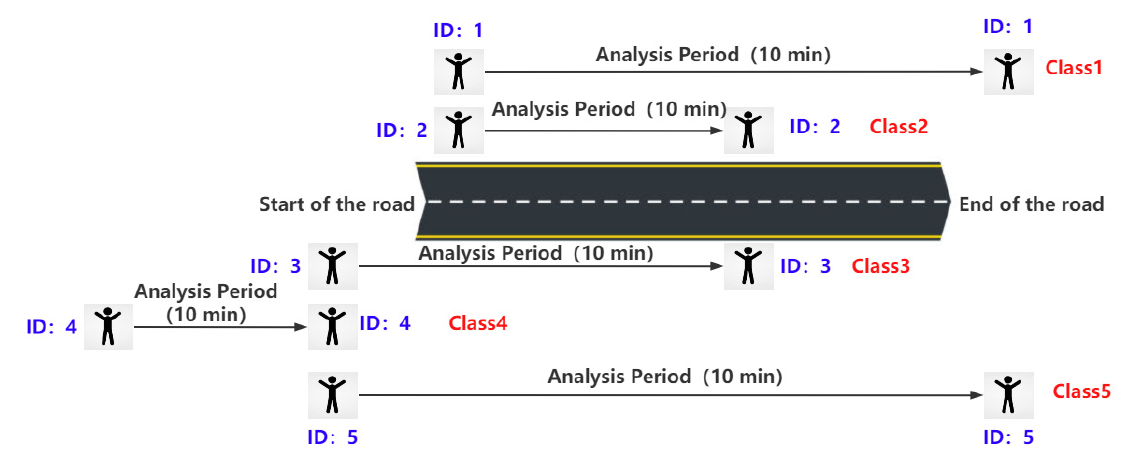
Figure 5. The five categories used to assess the road throughput.